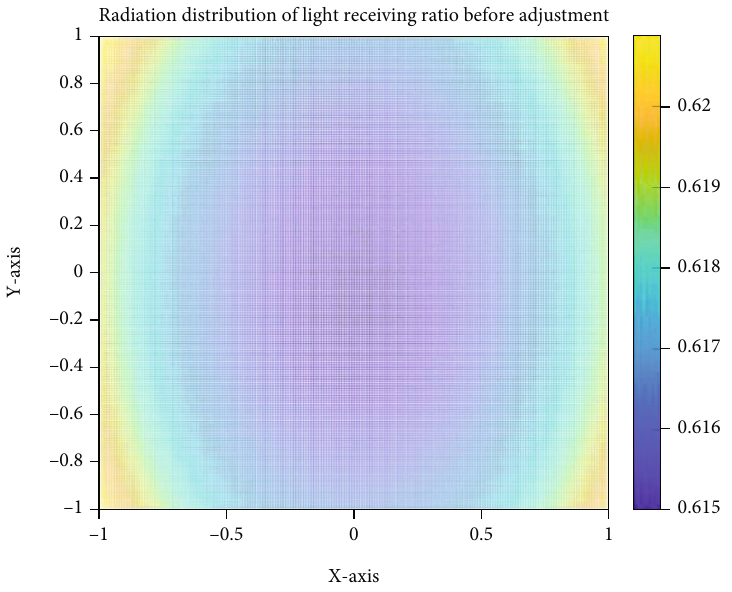
Figure 9: Distribution of electromagnetic wave reception ratio of parabolic re fl